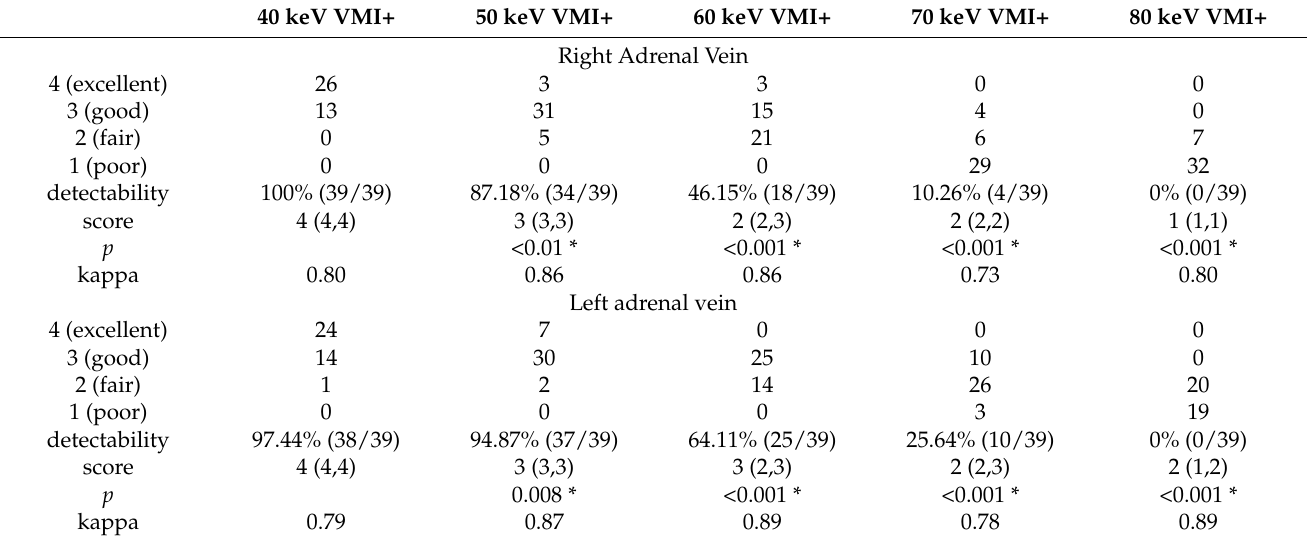
Scores are medians with interquartile ranges in parentheses. p values correspond to the comparison between the 40 keV images and the other energy level VMI+. * Significant difference ( p < 0.05). VMI+, advanced virtual monoenergetic images; keV, kiloelectron volt.